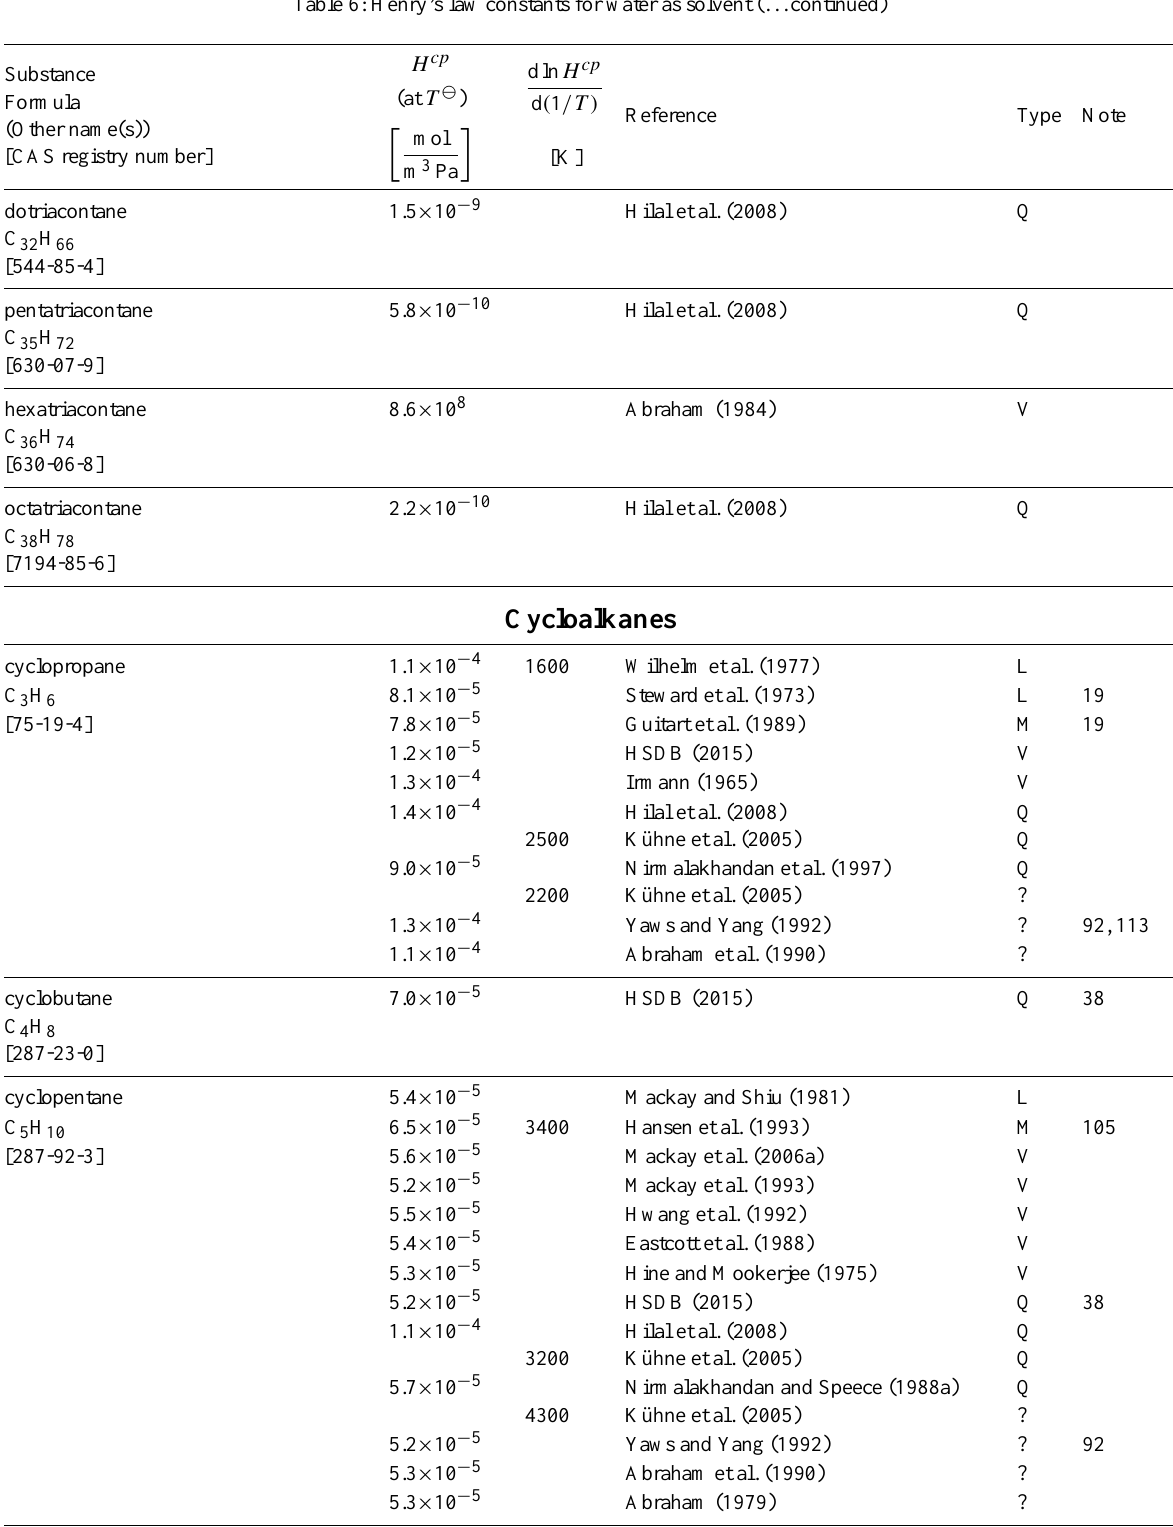
Table 6: Henry’s law constants for water as solvent